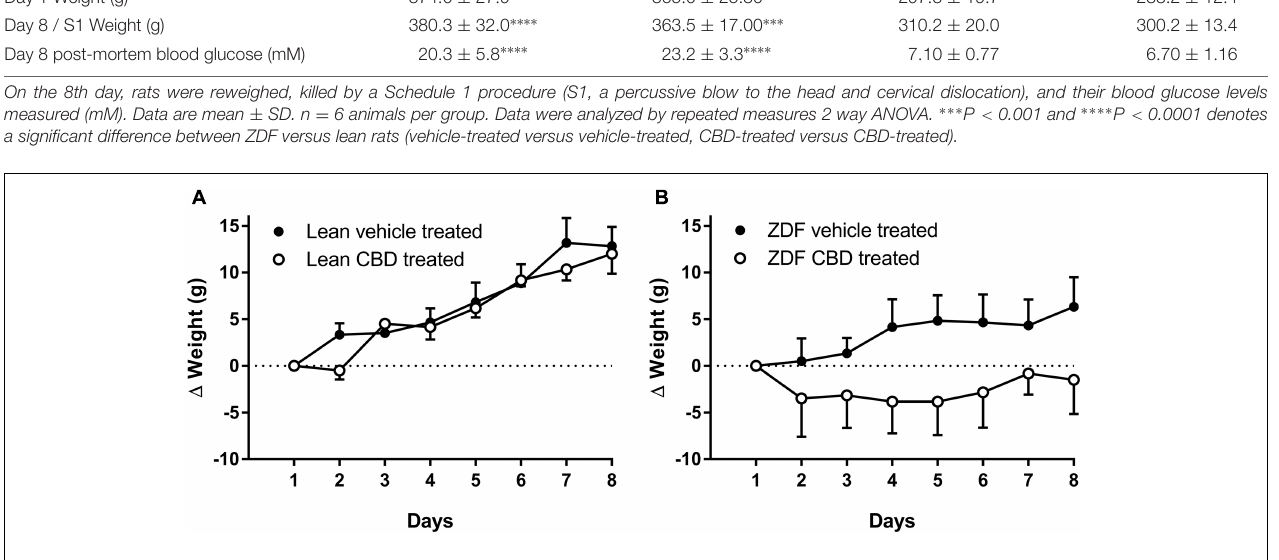
FIGURE 1 | Change in body weights ( (cid:49) g from Day 1 weight) of ZDF Lean (A) and ZDF rats (B) recorded daily during 7 days i.p. injection of vehicle or 10mg/kg CBD. On the 8th day, rats were killed by a Schedule 1 procedure. Data are mean ± SD. n = 6 animals per group. Data were analyzed by one-way ANOVA and Bonferroni post hoc test of selected